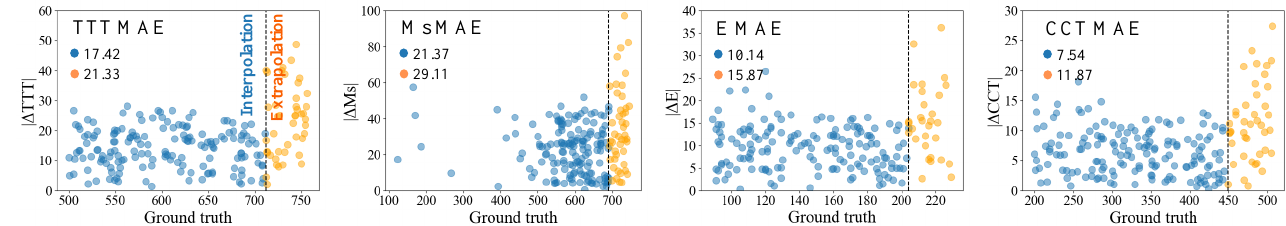
Figure 8. Absolute differences in predicted and experiment value against the experiment value range for the validation